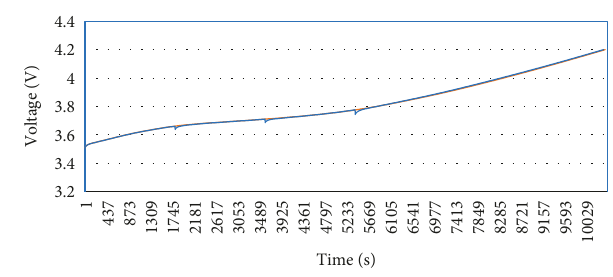
Figure 3: The scheme of capacity estimation.